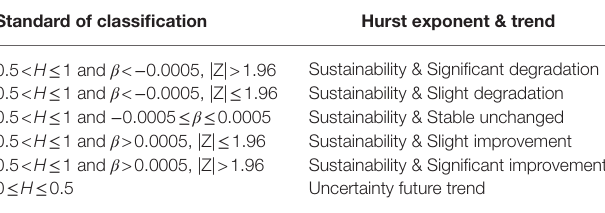
TABLE 1 | The rule of definition of the NDVI change